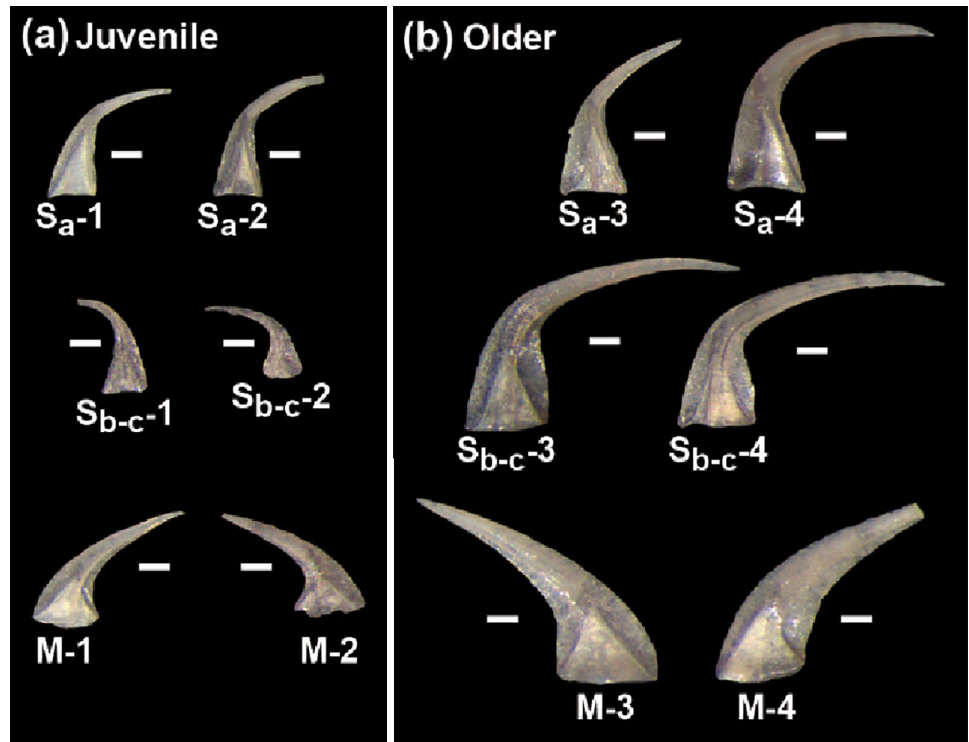
Figure 1. Reflected light photomicrographs of specimens of Dapsilodus obliquicostatus sampled in this study including all element types (S a , S b-c , and M elements). All scale bars are 100 μm and all images are scaled to